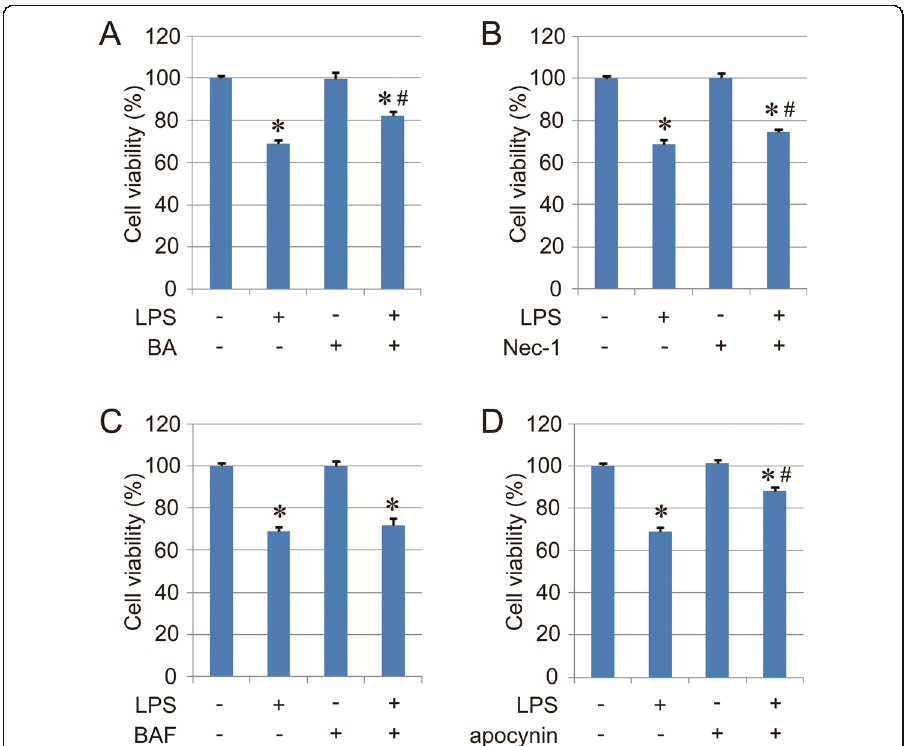
Fig. 7 Cell viability of BEAS-2B cells treated with LPS and different inhibitors. Bongkrekic acid (BA, 20 μ M, apoptosis inhibitor), necrostatin-1 (Nec-1, 50 μ M, necroptosis inhibitor), bafilomycin A1 (BAF, 50 nM, autophagy inhibitor), and apocynin (200 μ M, inflammation inhibitor) were used to rescue cell injury induced by LPS. Results are expressed as means±SEM ( n = 3). *: p < 0.05 compared with the control group. #: p < 0.05 compared with the LPS